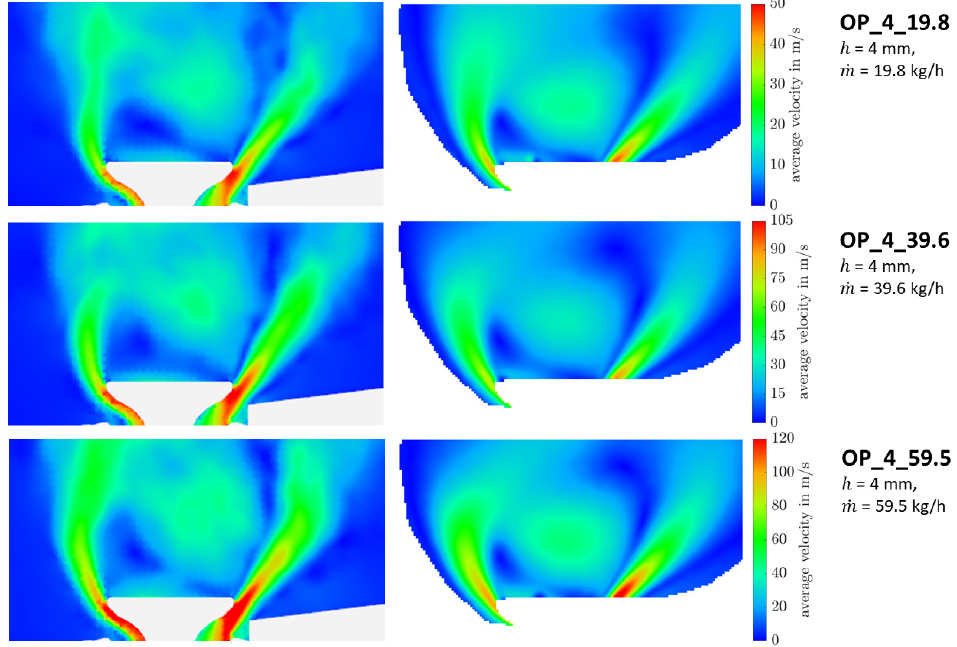
Figure 11. Comparison of time-averaged velocity fields for LES ( left ) and PIV ( right ) for the mass flow variation (note: adjusted colour coding).